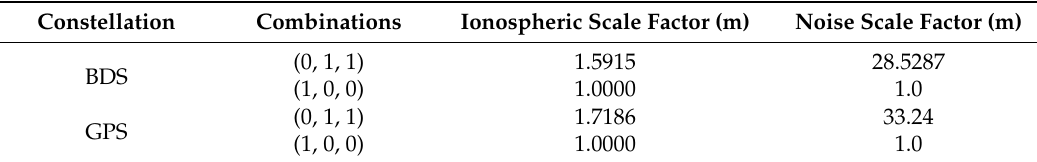
Table 2. Characteristics of the selected code